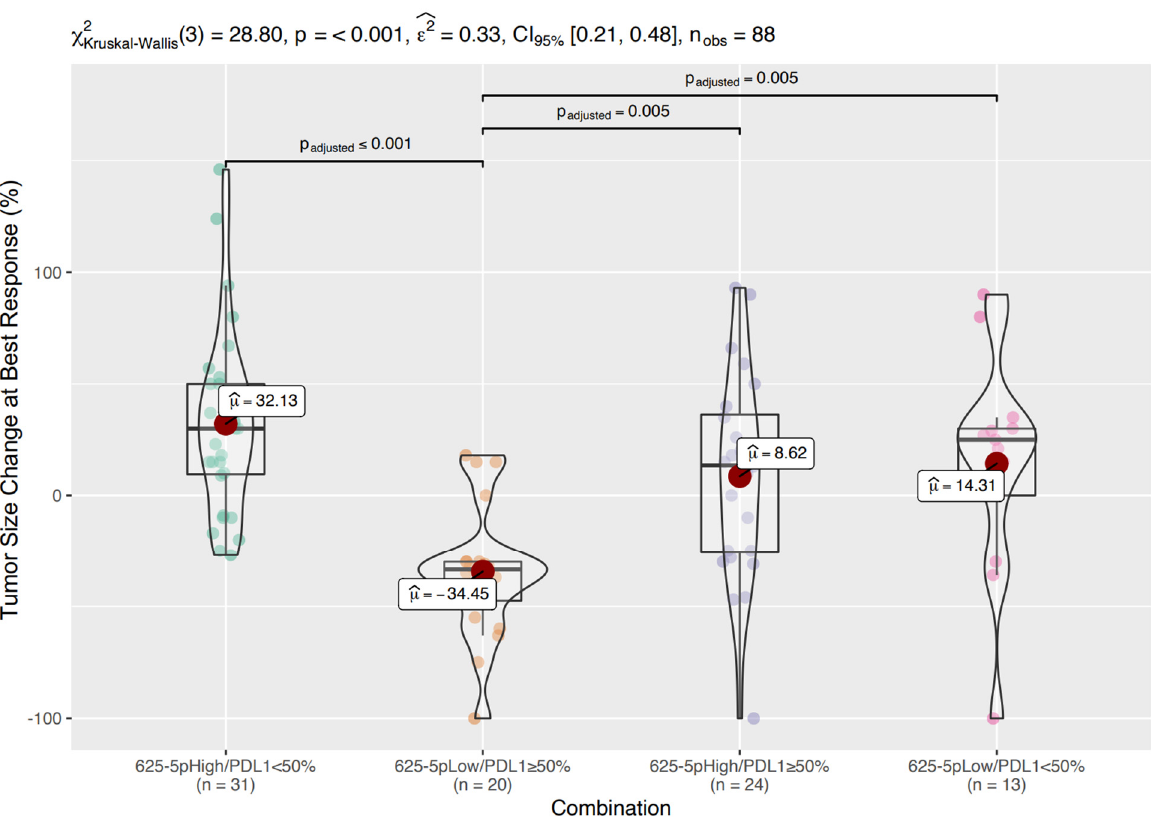
Figure 5. Tumor size changes according to miR − 625 − 5p/PDL − 1 expression Box/Violin plot representing the tumor size change at best response in the four classes of patients: miR − 625 − 5p High/PDL1 < 50%, miR − 625 − 5p Low/PDL1 ≥ 50%, miR − 625 − 5p High/PDL1 ≥ 50% and miR − 625 − 5p Low/PDL1 < 50%.